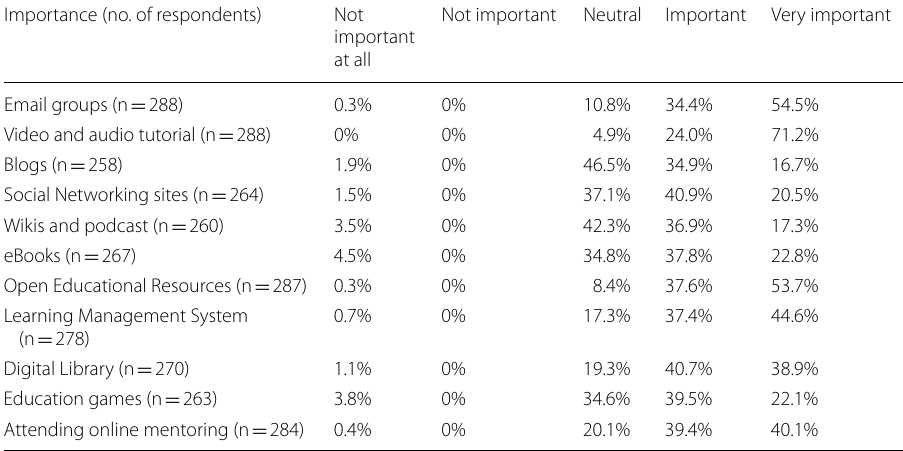
Table 4 Importance of various online resources related to e-learning, as reported by the student cohort